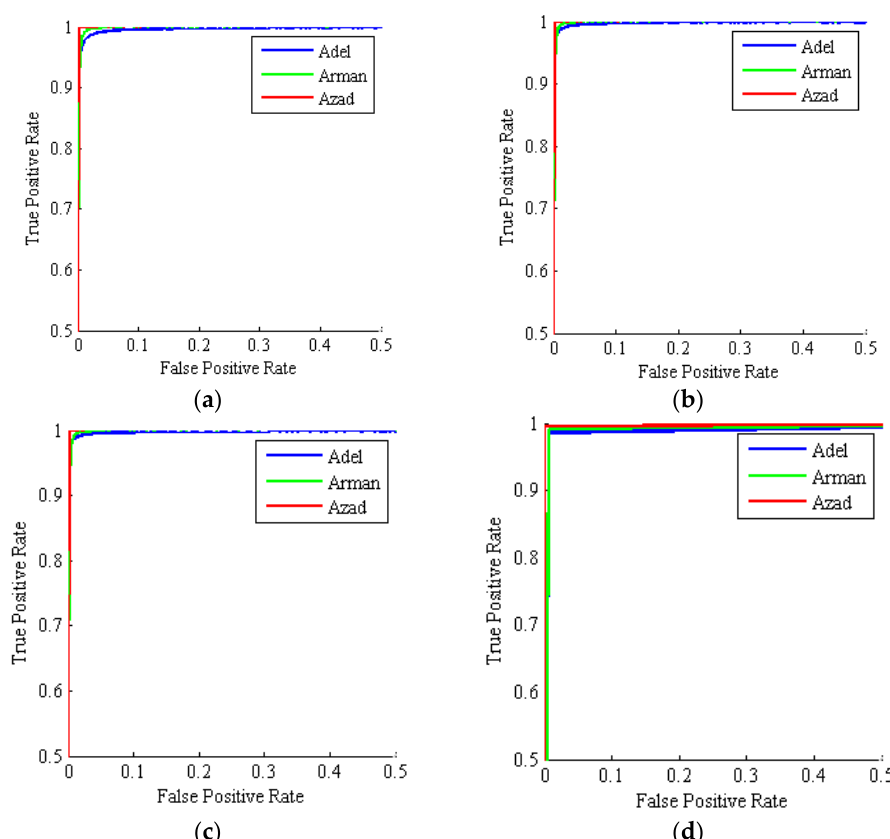
Figure 9. Mean ROC curves for three chickpea varieties: Adel (blue), Arman (green), Azad (red). ( a ) ANN-PSO; ( b ) ANN-ACO; ( c ) ANN-HS; ( d ) ANN-PSO/ACO/HS Majority-Voting ensemble (1000 simulations, test set). Table 9. Comparison of the performance of the four classifiers (ANN-PSO, ANN-ACO, ANN-HS and ensemble ANN PSO/ACO/HS-MV): recall, specificity, precision, f1-score, AUC and accuracy (1000 iterations, test set).